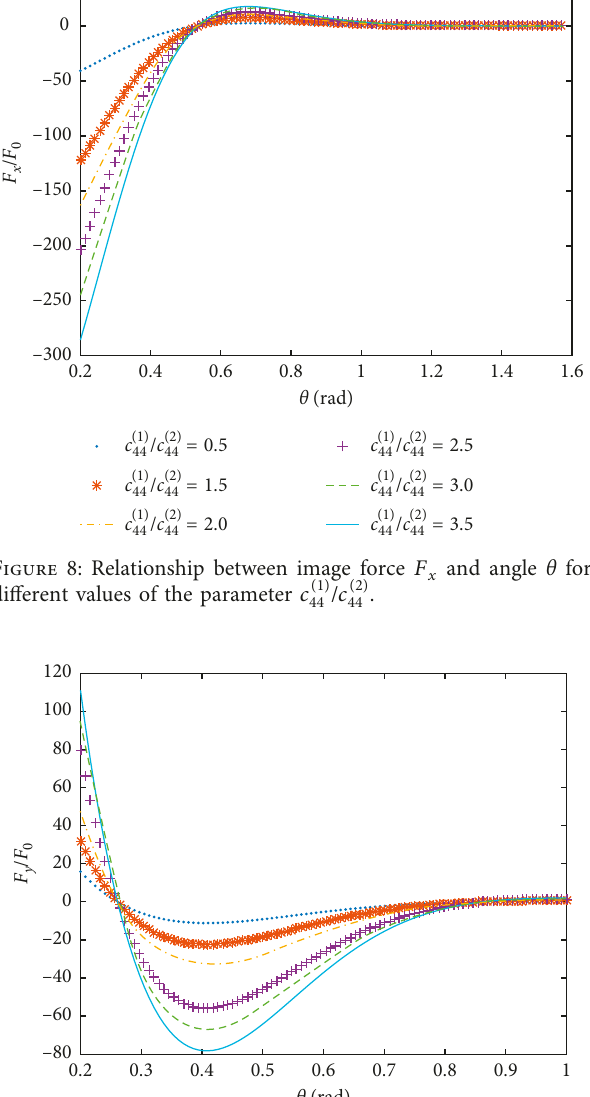
Figure 7: Force on the dislocation b angular position θ .